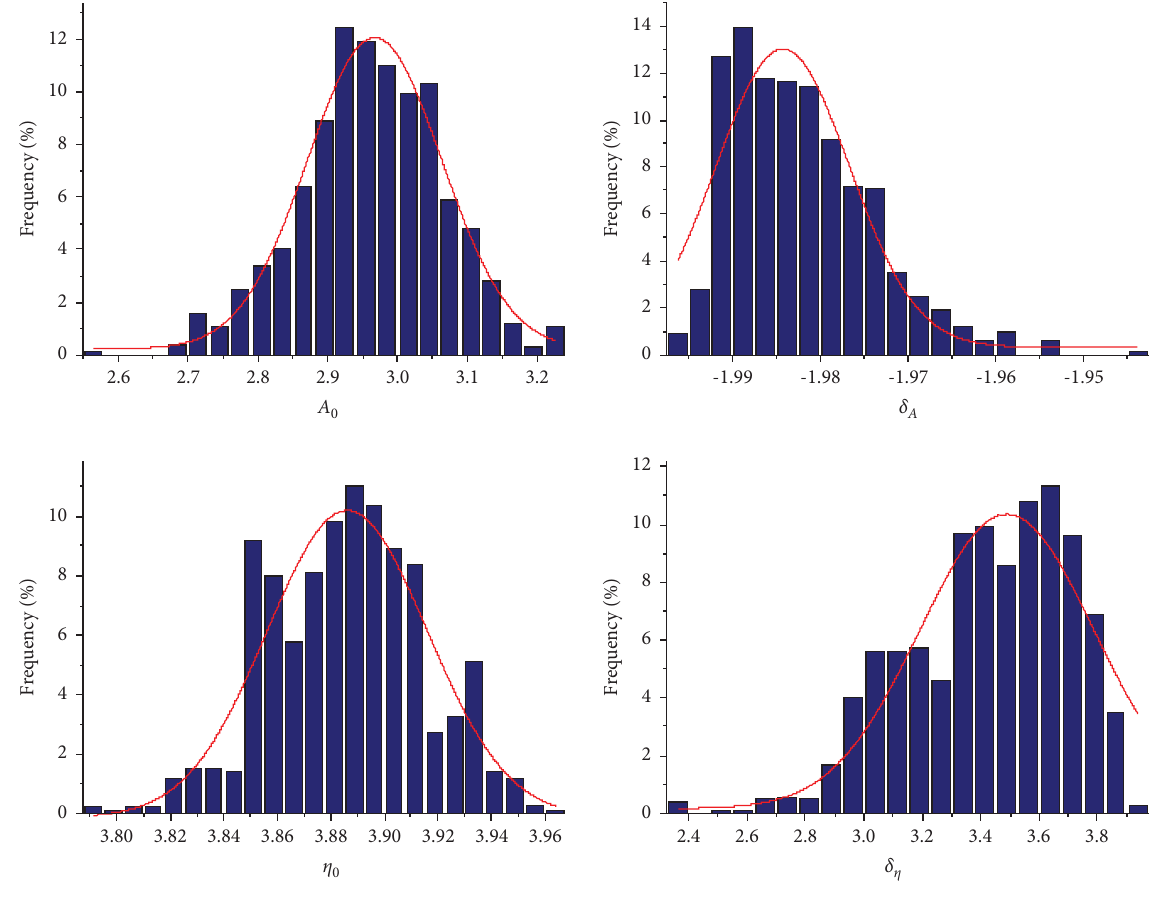
Figure 7: Probability distribution of each parameter.